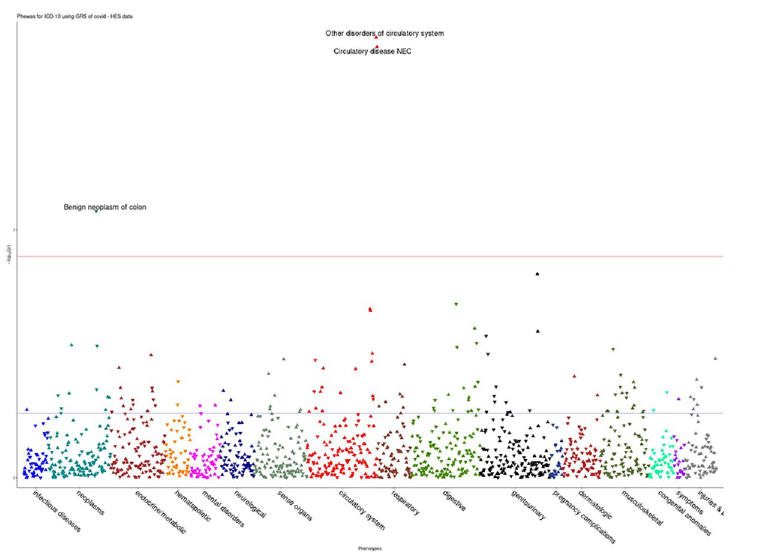
Fig 4. PheWAS associations for COVID-19 susceptibility in HES